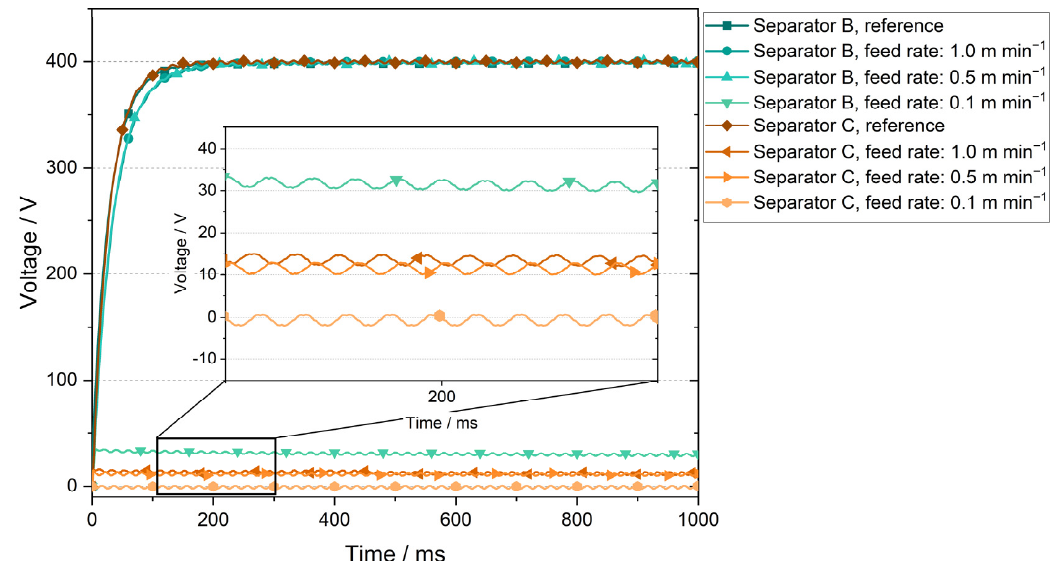
Figure 4. Results of high potential tests for separators B and C at a voltage of 400 V and an applied area pressure of 0.3 Nmm − 2 . area pressure of 0.3 Nmm − 2